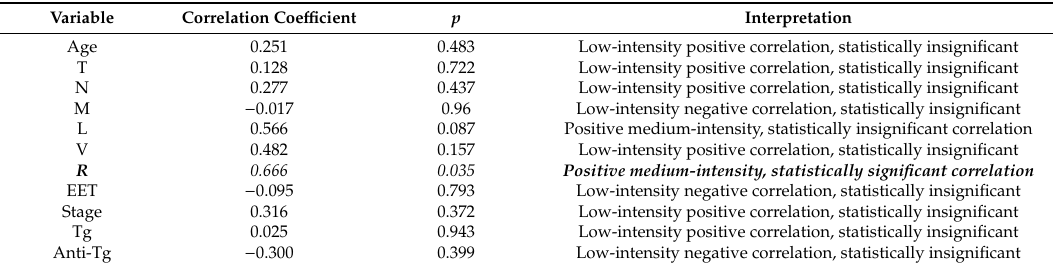
Table 5. Analysis of the correlation between the SUV and prognostic factors in the subgroup of patients with BRAF +